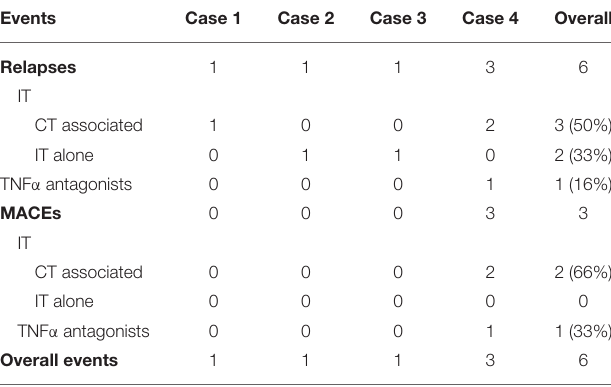
TABLE 2 | Relapses and MACEs in our